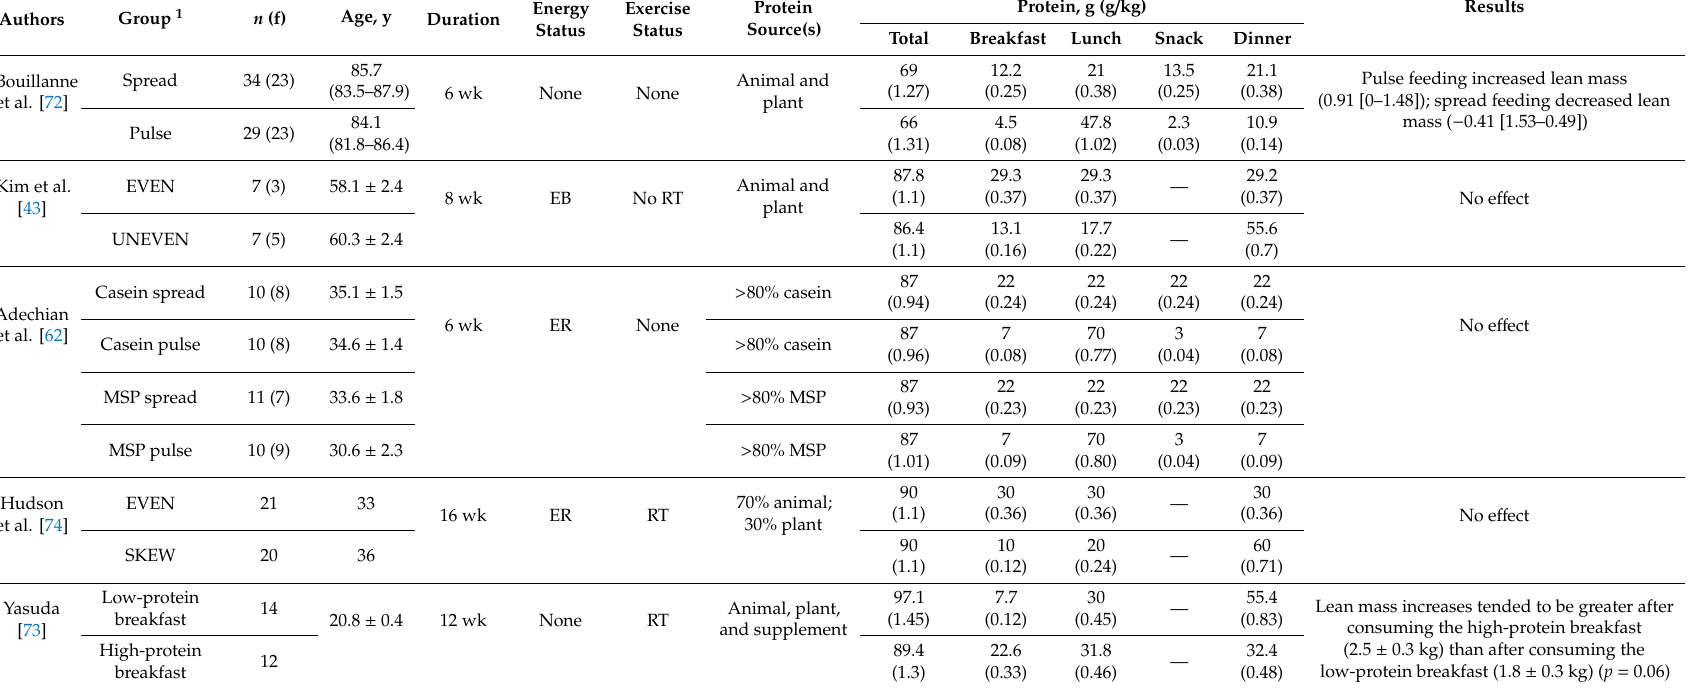
Table 4. Chronic protein ingestion research assessing the e ff ect of protein distribution on body